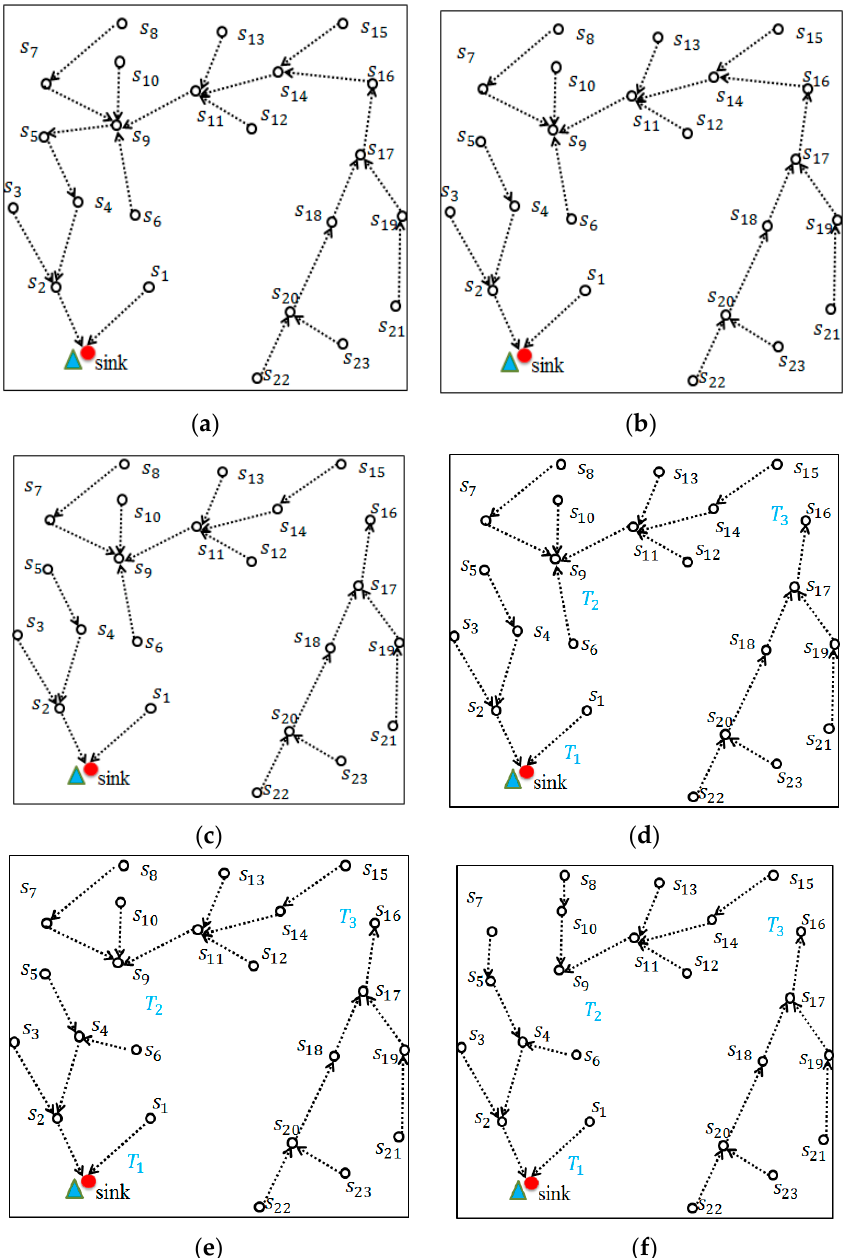
Figure 2. An example of network partition phase. ( a ) Given a minimal spanning tree; ( b ) Selecting sensor node s 9 as subroot; ( c ) Selecting sensor node s 16 as new root; ( d ) Three subtree T 1 , T 2 and T 3 ; ( e ) Selecting sensor node s 6 to move from T 2 to T 1 ; ( f ) Selecting sensor node s 7 to move from T 2 to T 1 .